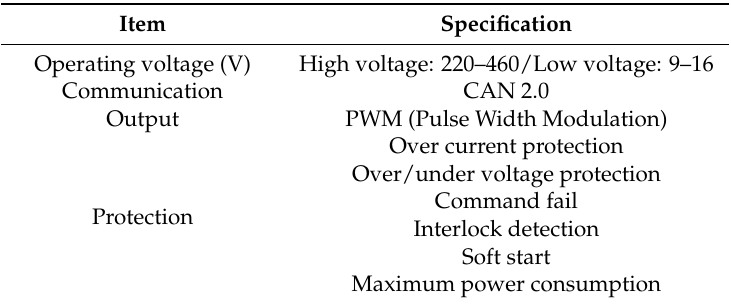
Figure 4. PCB of the controller and other components of the heating system. Table 4. Specifications of the controller of the high-voltage heating system.